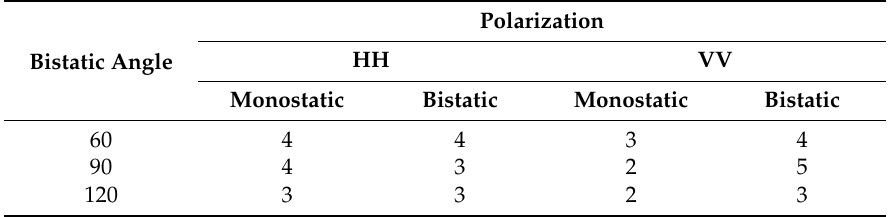
Table 6. 3MD distribution: minimum number of modes required to accurately match the NetRAD data.